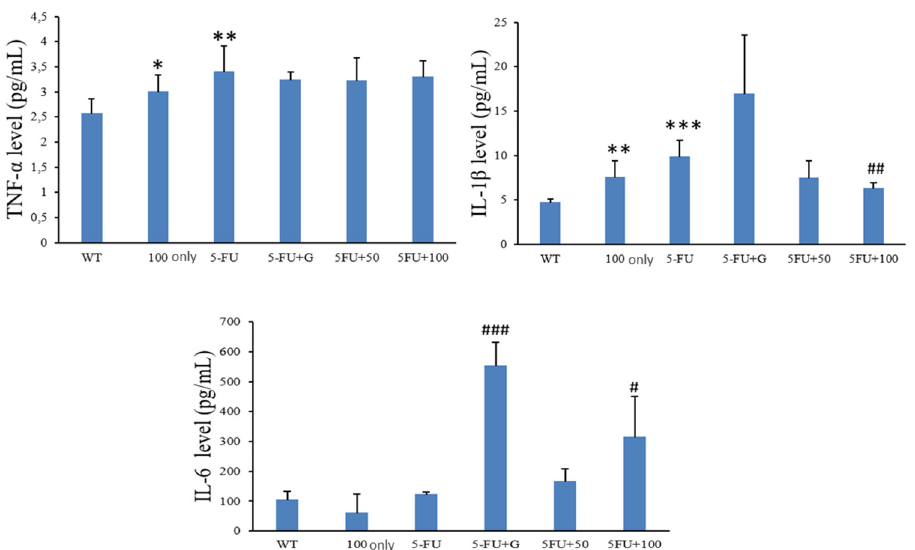
Figure 7. The serum levels of TNF- α , IL-1 β , and IL-6 in the six experimental groups. *, **, and *** show significant differences with the WT group with p <0.05, p <0.01, and p <0.001, respectively. # , ## , and ### show significant differences with the 5-FU group with p <0.05, p <0.01, and p <0.001, respectively.